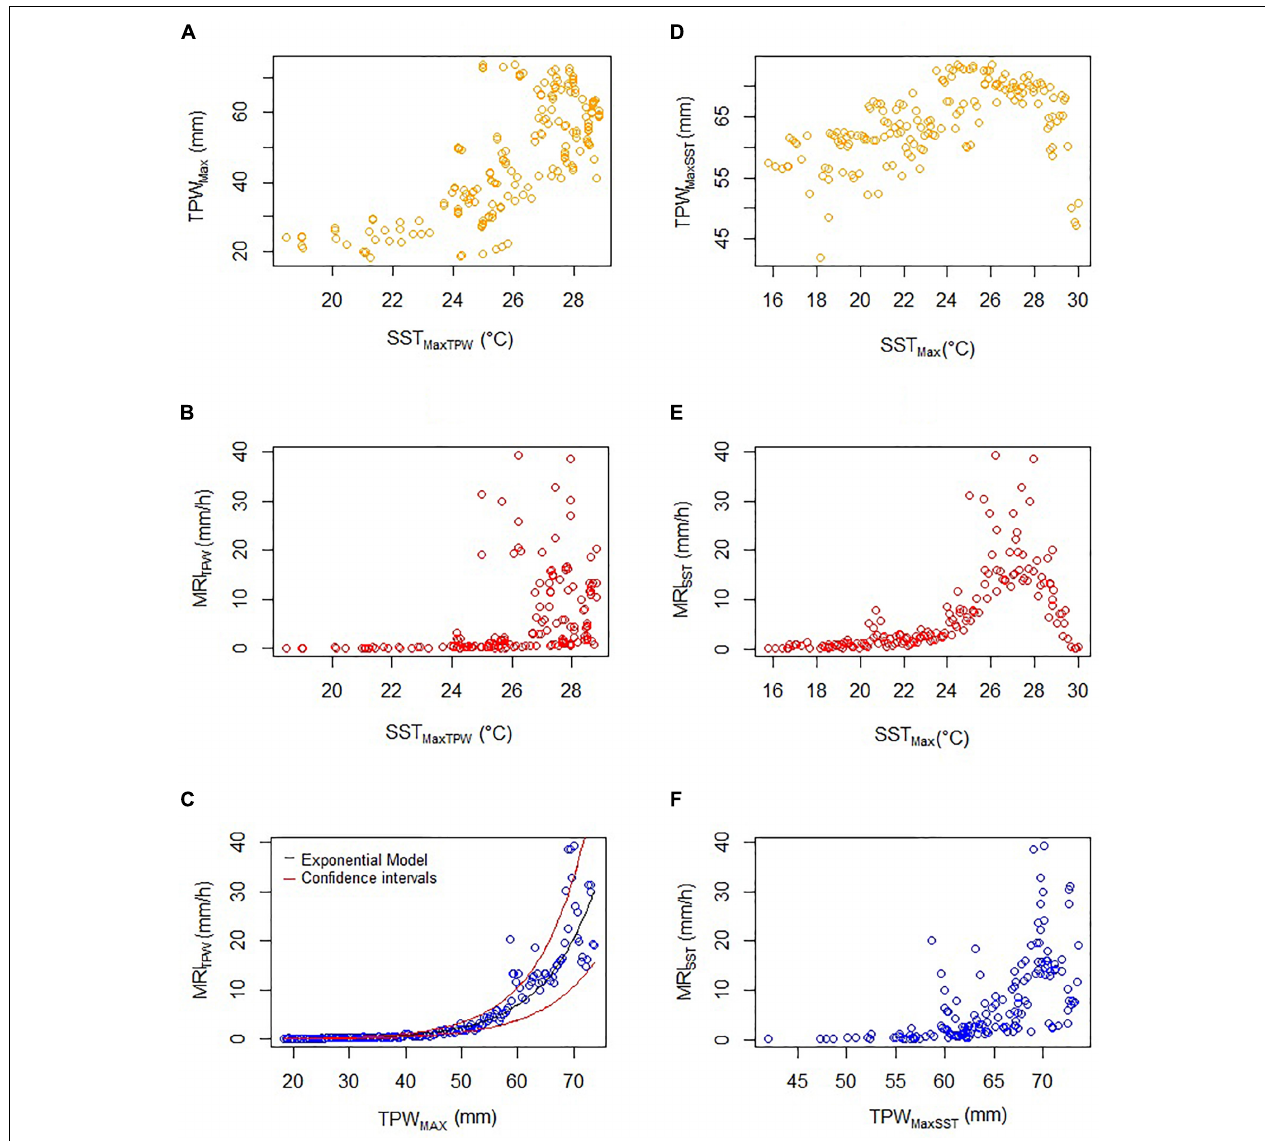
FIGURE 4 | MRI points associated with TPW (left side): (A) TPW Max vs. SST MaxTPW ; (B) MRI TPW points and their corresponding SST values (SST MaxTPW ); (C) MRI TPW associated with the TPW MAX bins, including the adjusted exponential model selected (continuous black line) and the 95 percent confidence intervals (red lines). Right side: MRI points associated with SST: (D) TPW MaxSST vs. SST Max ; (E) MRI SST points and their corresponding SST values (SST Max ); (F) MRI SST associated with TPW MaxSST